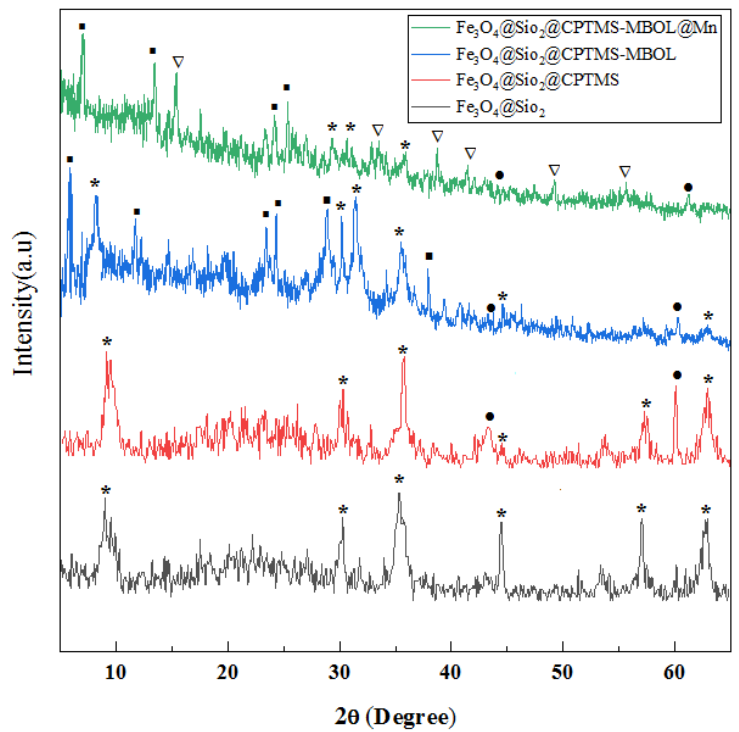
Figure 2. The XRD pattern of Fe 3 O 4 @SiO 2 @CPTMS@MBOL@Mn.